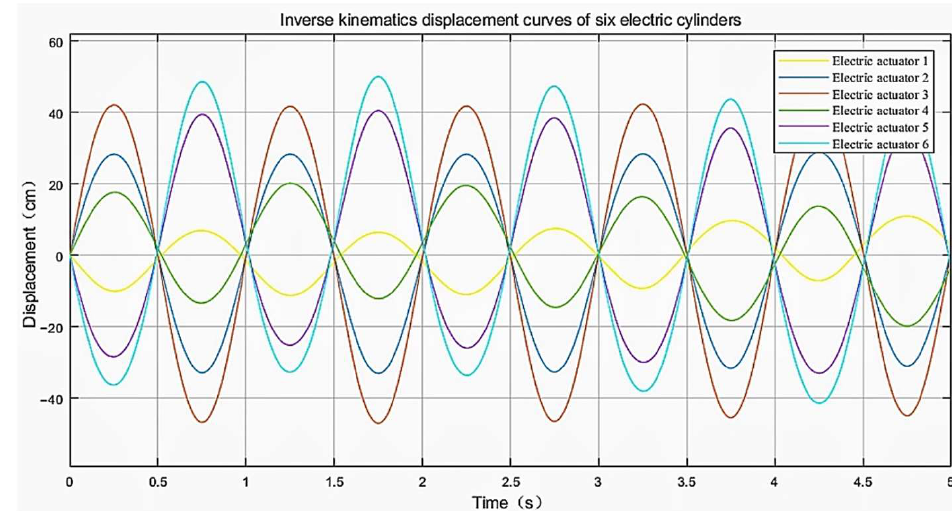
Figure 8. Telescopic curve of electric cylinder rotating around X and Y axes.